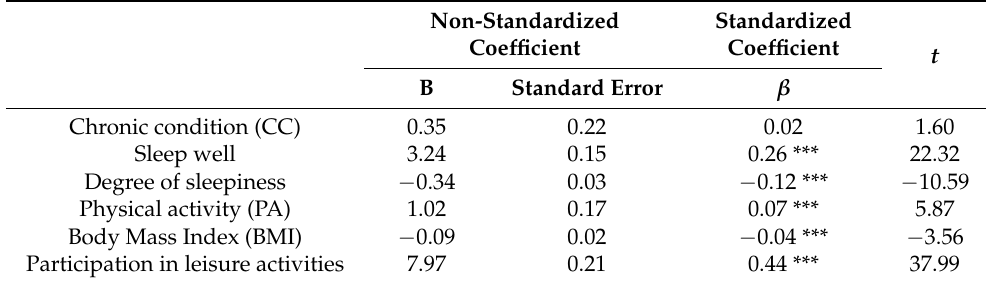
Table 4. Linear regression model of variables for the study of the QoL—predictors: CC and variables associated with lifestyle (sleep, physical activity, BMI, and leisure).